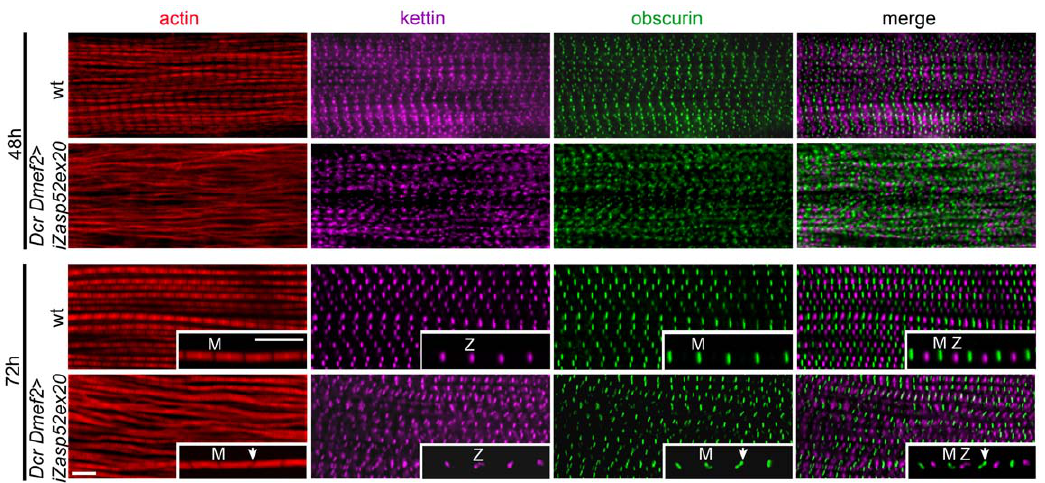
Figure 4. Zasp52 long isoforms are required for pupal myofibril development. Wild type and Dcr Dmef2 . iZasp52ex20 IFM myofibrils stained with phalloidin (red), anti-obscurin (green) and anti-kettin (magenta) antibody at 48 and 72 h APF. Compared to wild type, myofibrillar defects are visible in Dcr Dmef2 . iZasp52ex20 IFM at 48 h APF. Obscurin labeling in the M-line and kettin labeling in the Z-disc is less ordered compared to the wild type. Myofibrils are thinner and not well structured. At 72 h APF, some myofibrils are frayed and Z-discs and M-lines are deformed (arrowheads). Inserts show single myofibrils at higher magnification. Pupae were staged at 29 u C. Scale Bar, 5 m m.